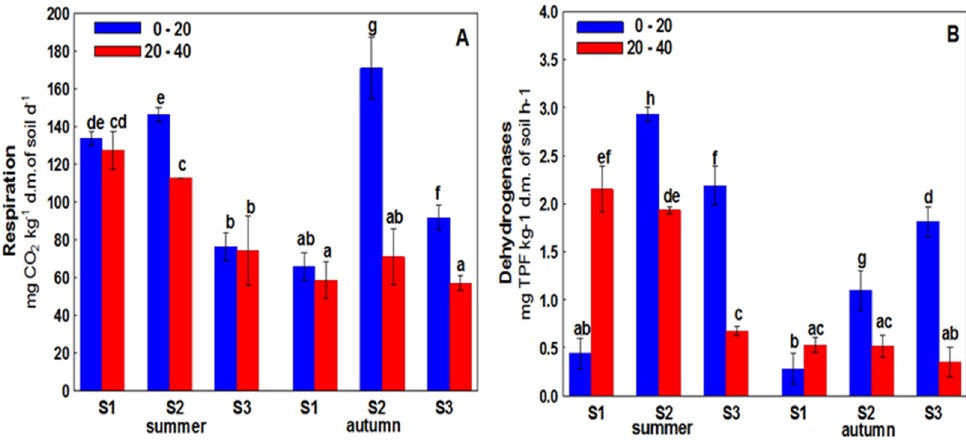
Figure 2. Biochemical and enzymatic activity in soil from 0–20 and 20–40 cm depths: ( A ) respira- tion; ( B ) dehydrogenases activity. Legend: S1, S2, S3—sampling sites located S1—5.88, S2—22.7 and S3—50.08 m from the reservoir with liquid post-production waste. Vertical lines indicate the standard deviation. Different letters above the columns indicate significant differences at p < 0.05.